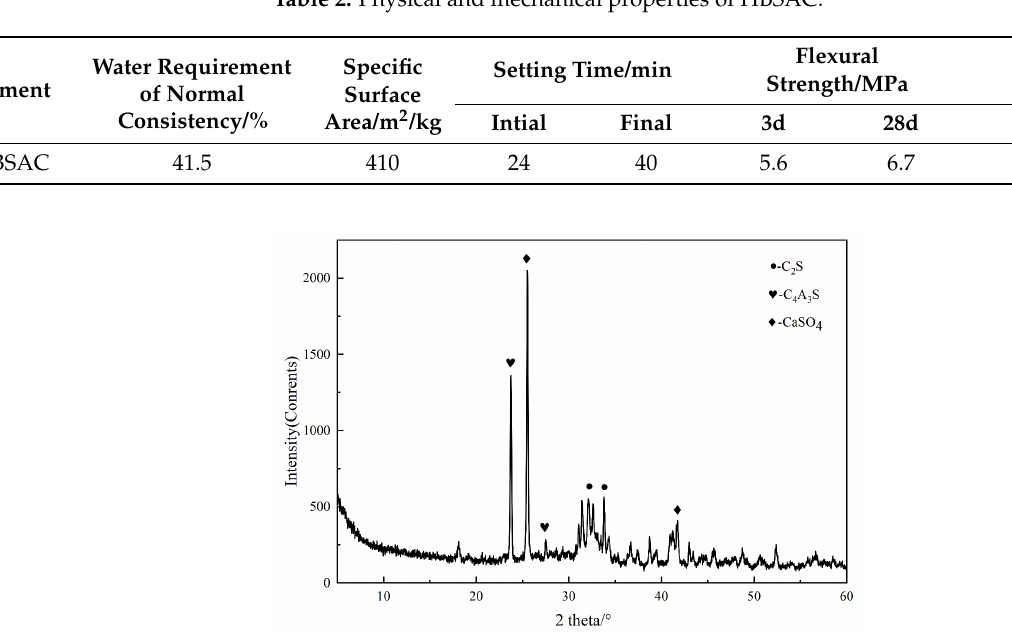
Figure 1. The XRD analysis of HBSAC.